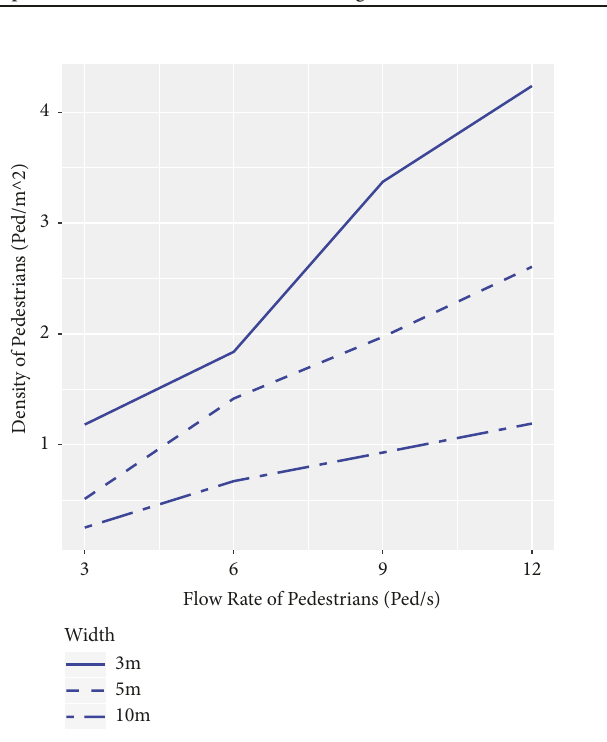
Figure 11: Pedestrians’ density transformation over the pedestrian flow rate in the different scenarios.